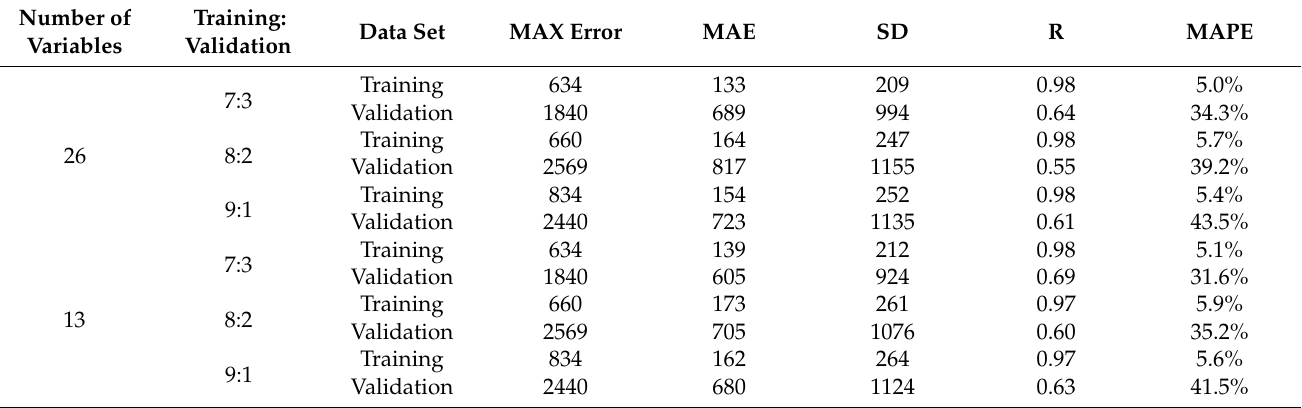
Table A14. Analysis of the results of the CART model for natural gas